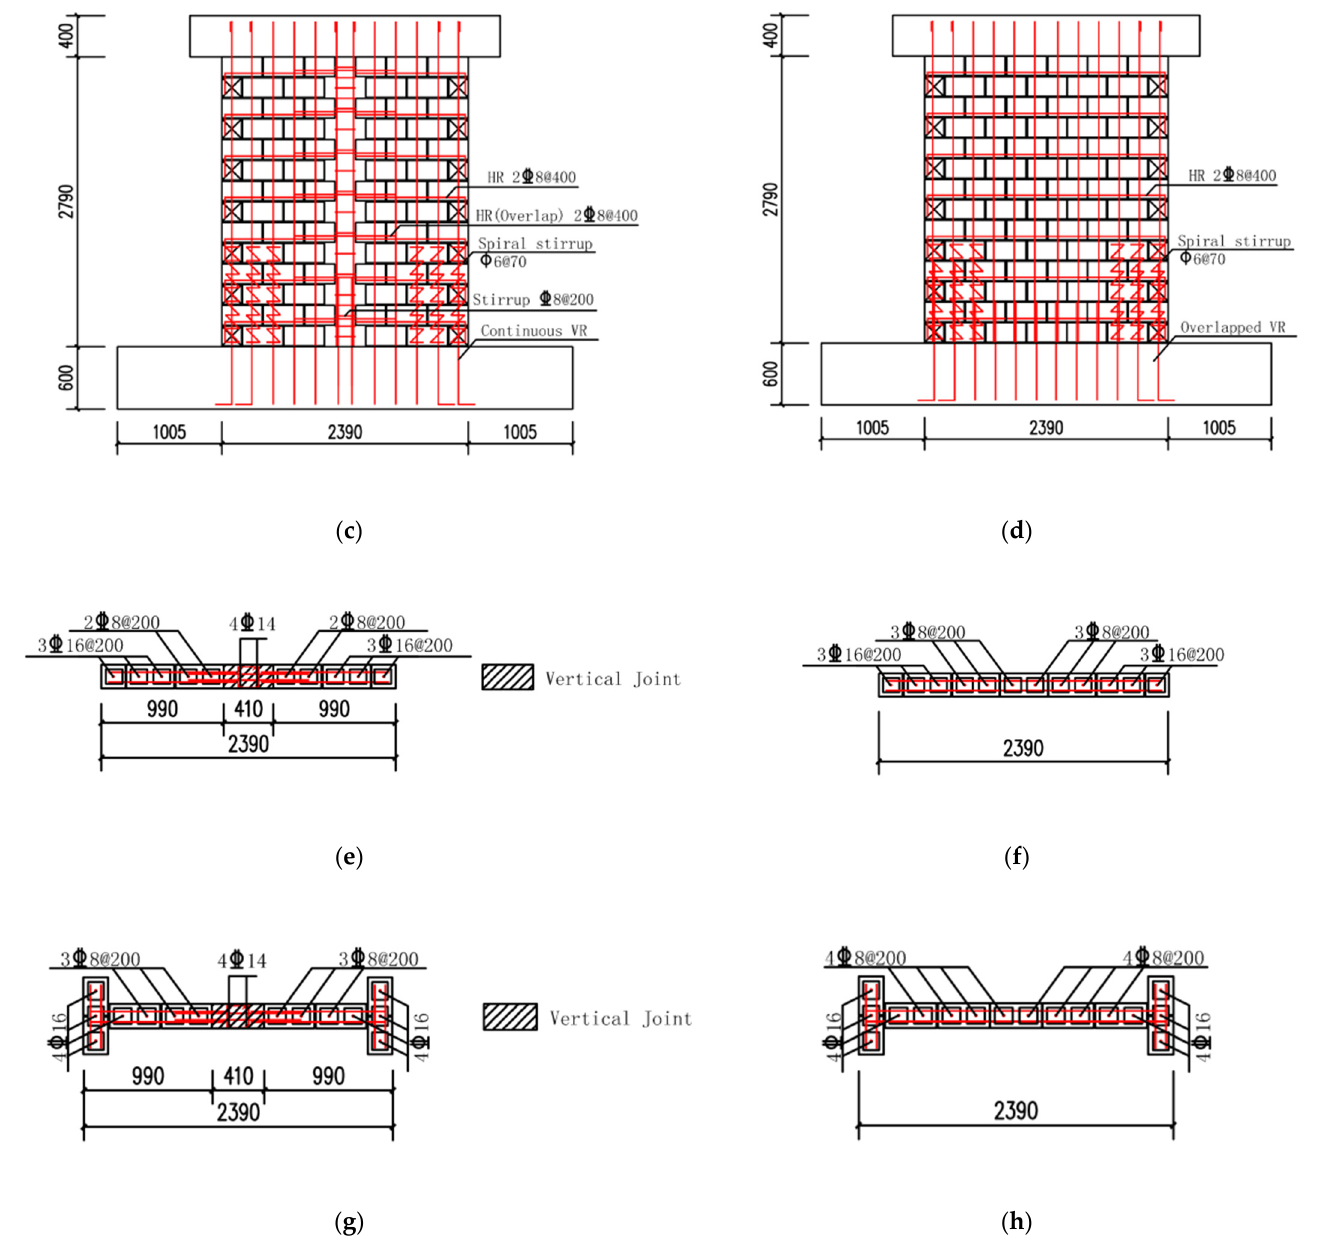
Figure 1. Configuration and reinforcement details of test specimens: ( a ) Front view of PCMW; ( b ) Front view of CMW; ( c ) Front view of PCMWT; ( d ) Front view of CMWT; ( e ) Reinforcement configuration of PCMW; ( f ) Reinforcement configuration of CMW; ( g ) Reinforcement configuration of PCMWT; ( h ) Reinforcement configuration of CMWT.